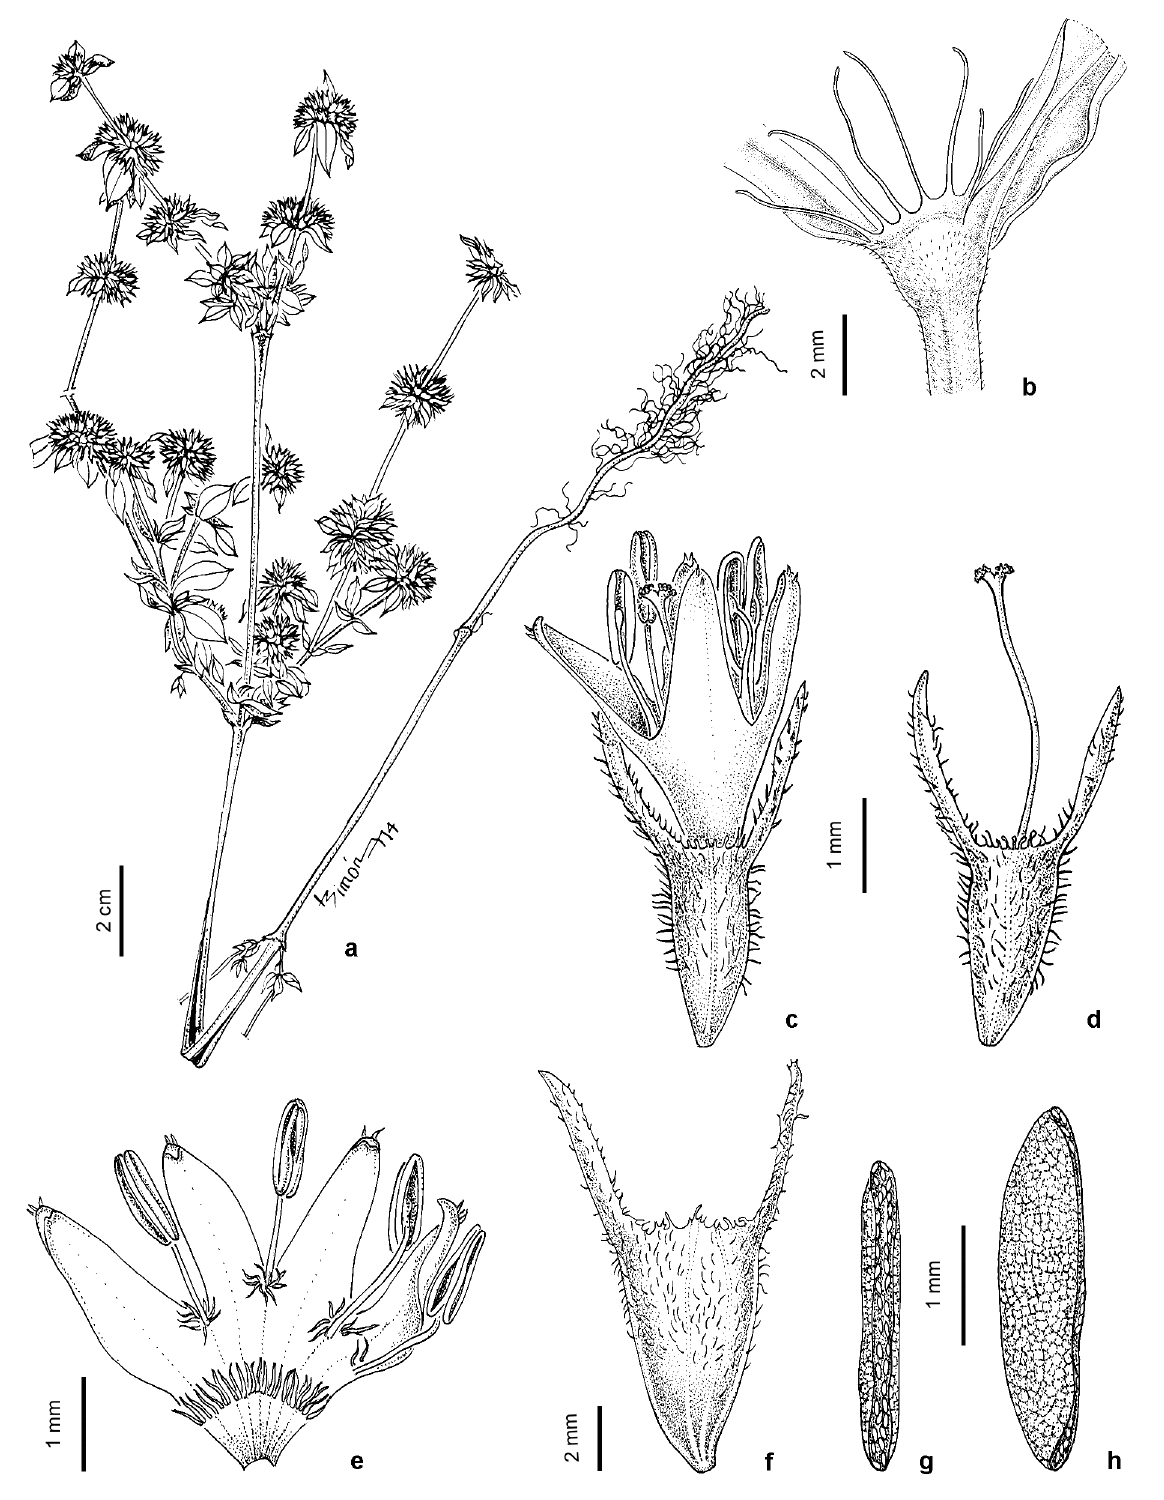
Figure 5 - Borreria diacrodonta , a . Habit; b . Stipular sheath; c . Flower; d . Hypanthium, calyx lobes, style, and stigma; e . Open corolla; f . Fruit; g . Seed, ventral view; h . Seed, lateral view. (Illustration: L. Simón